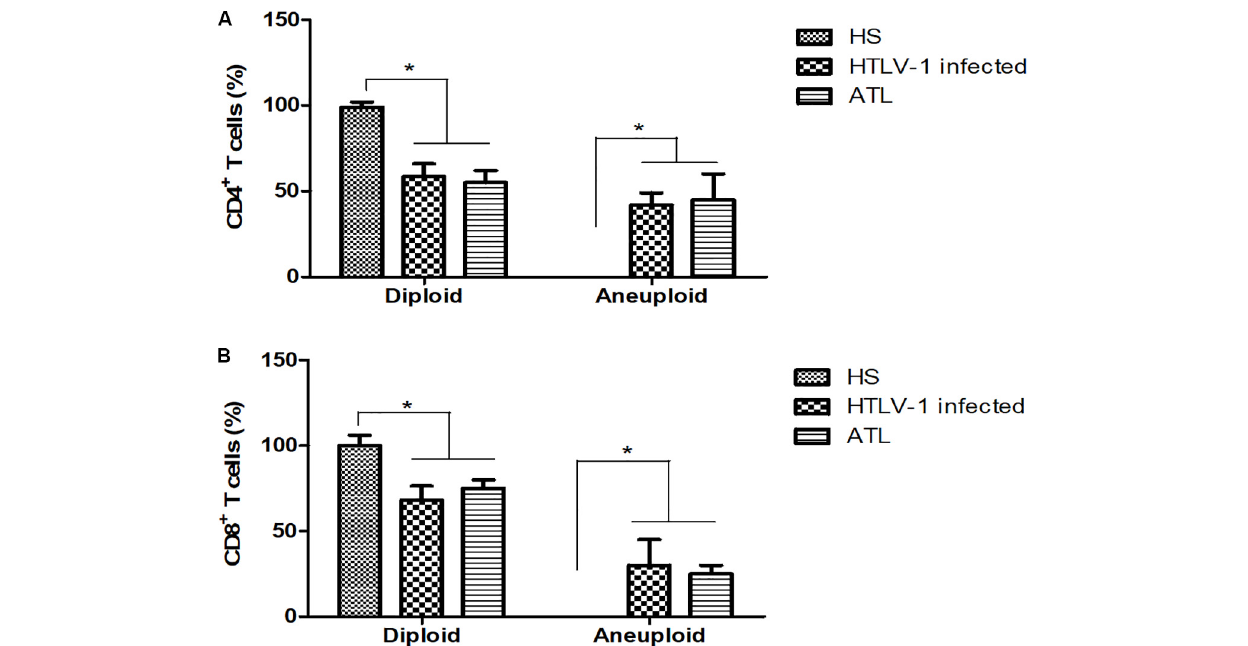
FIGURE 3 | Percentage of CD4 + and CD8 + T cells with diploid and aneuploidy cells. (A) CD4 + T cells; (B) CD8 + T cells. HS, Health subjects; HTLV-1 infected, HTLV-1 Asymptomatic carriers; ATL, Adult T-cell leukemia/lymphoma. * P < 0.005.